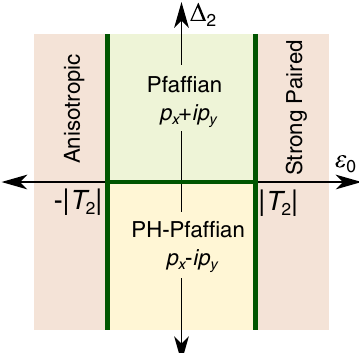
FIG. 2. Phase diagram for m odd as a function of parameters ϵ 0 and Δ 2 in Eq. (58).